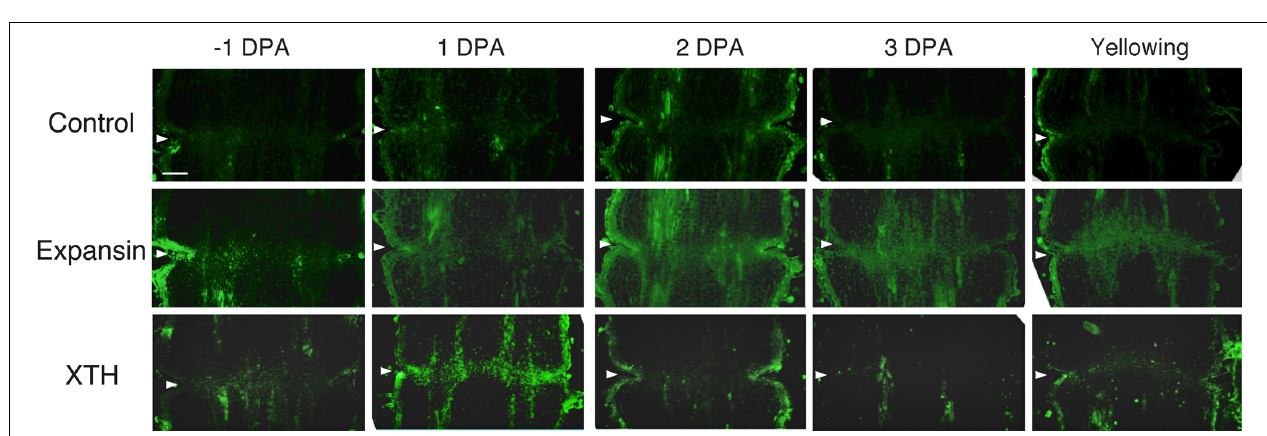
pedicels, including the AZ, were stained with the anti-expansin and anti-xyloglucan antibodies. Micrographs show the negative control without the first antibody step. Arrowheads indicate the AZs. Bar = 0.2